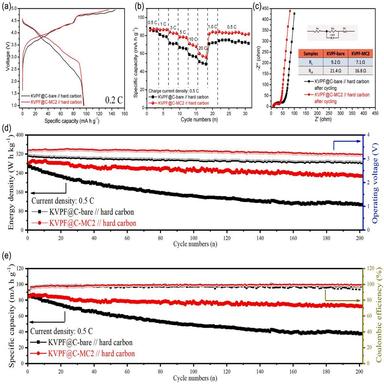
Electrochemical properties of KVPO4F//HC full-cells: (a) 1st charge–discharge curves at 0.2C; (b) Rate performance with charge current density of 0.5C; (c) EIS impedance spectra of the cells after cycling; (d) Energy densities and operating voltages during cycling at 0.5C; (e) Specific capacities and coulombic efficiencies during cycling at 0.5C.